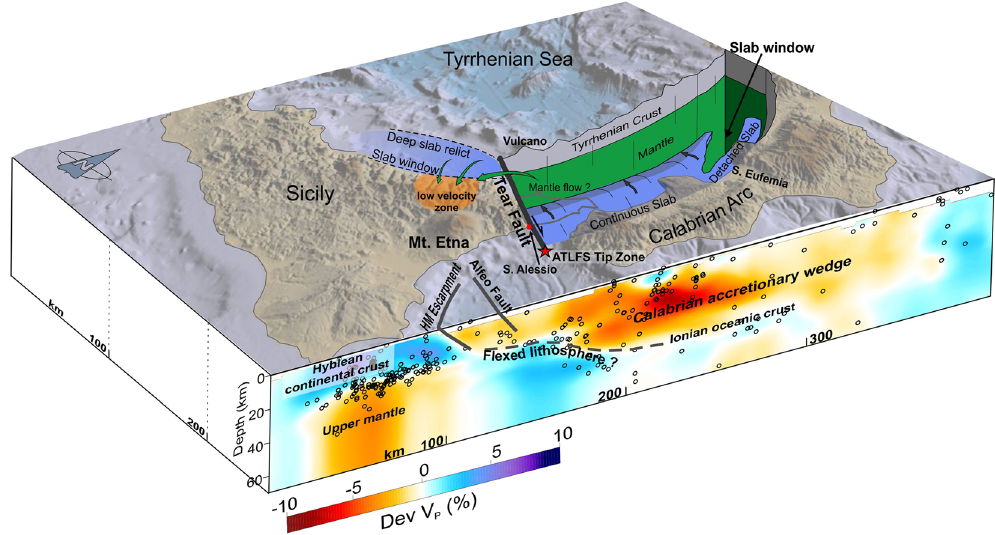
Figure 7. 3D sketch summarizing the main features deriving from this study. Topography is from ref. 46 . The figure was obtained using the software Move (version 2017.2; https://www.mve.com) and Corel Draw Graphics Suite (version X5;